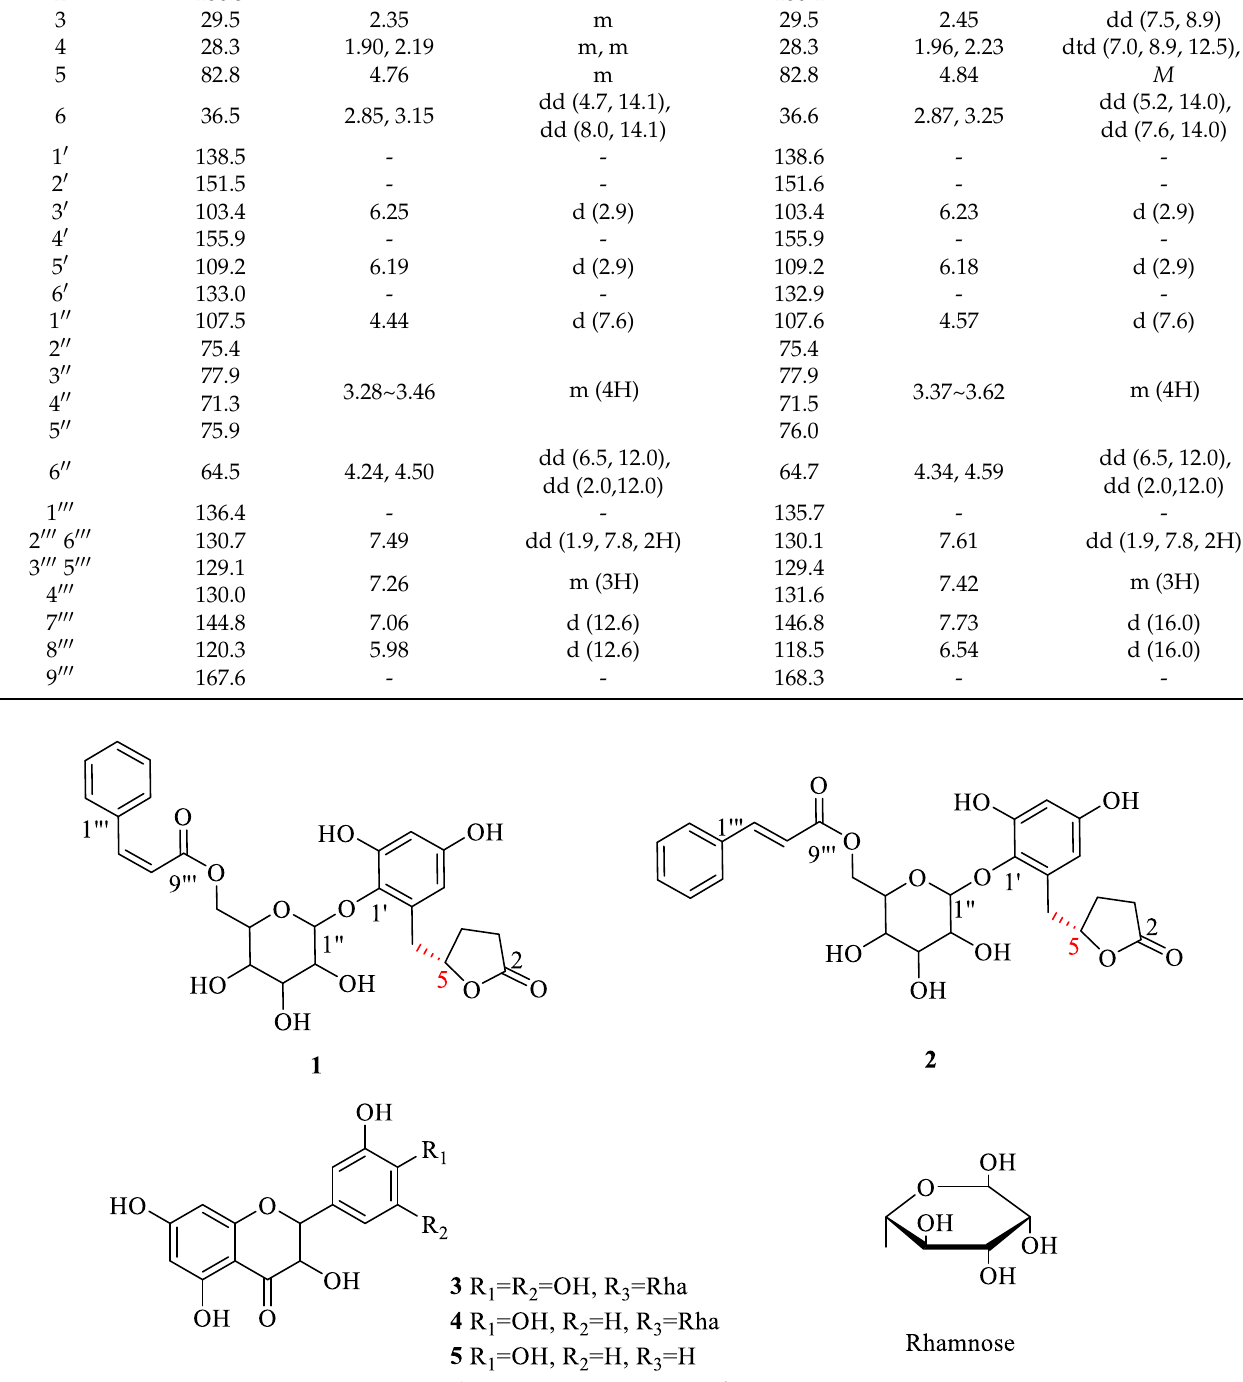
Figure 2 . The structures of compounds 1 − 6 from the leaves of A. crenata Sims. Figure 2. The structures of compounds 1 – 6 from the leaves of A. crenata